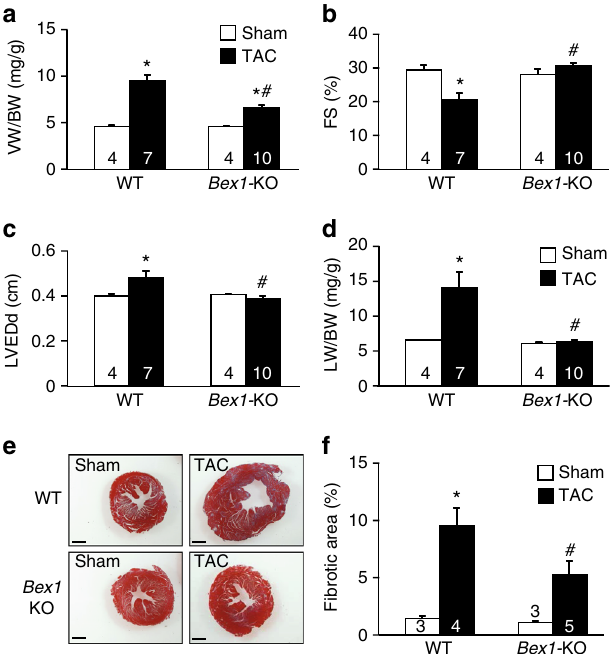
Fig. 2 Bex1 gene deletion protects from pressure-overload-induced heart failure. a VW/BW ratio from WT control and Bex1 -KO mice subjected to sham or 5 weeks of TAC. b Echocardiographic analysis of fractional shortening (FS%) in WT control and Bex1 -KO mice subjected to sham or 5 weeks of TAC. c Echocardiographic analysis of left ventricular end- diastolic diameter (LVEDd) in WT control and Bex1 -KO mice subjected to sham or 5 weeks of TAC. d LW/BW ratio from WT control and Bex1 -KO mice subjected to sham or 5 weeks of TAC. e Representative Masson ’ s trichrome-stained cardiac histological sections for fi brosis (blue) in mice of the indicated genotype and treatment. Original magni fi cation is 4×. Scale bars are 0.5 mm. f Quanti fi cation of fi brosis from Masson ’ s trichrome- stained sections from WT and Bex1 -KO hearts with sham or TAC surgery using ImageJ software. * P < 0.05 vs. sham; # P < 0.05 vs. WT TAC. P values are one-way ANOVA with Bonferroni correction. Number of mice analyzed is shown in the bars of each graph. All error bars represent